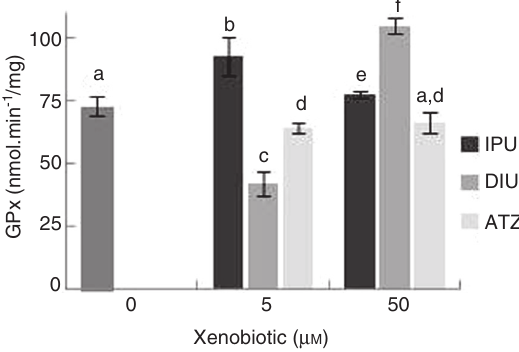
Figure 4: GSH/GSSG ratio determined in post-12,000 g supernatant Figure 6: GPx activity of post-12,000 g supernatant of Saccharo- grown in the absence or pres- grown in YEPD medium, in the absence or of Saccharomyces cerevisiae UE-ME myces cerevisiae UE-ME 3 3 ence of IPU, DIU and ATZ, in YEPD medium. presence of IPU, DIU and ATZ. The results represent the mean of five independent experiments ± The results represent the mean of five independent experiments ± SEM. The bars marked with different letters are significantly differ- SEM. The bars marked with different letters are significantly differ- ent (p < 0.01). ent (p <